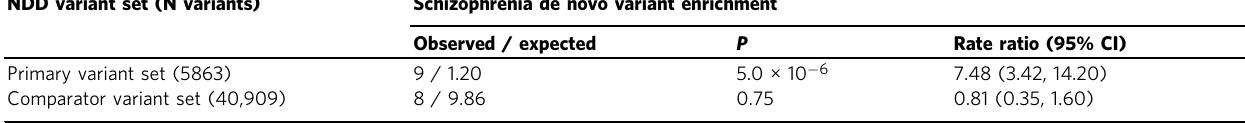
neurodevelopmentalvariantsannotatedasPTVsingeneswithpLiscores<0.9,missensevariantswithMPCscores<2andallsynonymousvariants.EnrichmentstatisticsweregeneratedusingaPoisson rate ratio test. P -values are uncorrected and two-tailed. PTVs protein-truncating variants, NDD neurodevelopmental disorders, CI con fi dence interval.